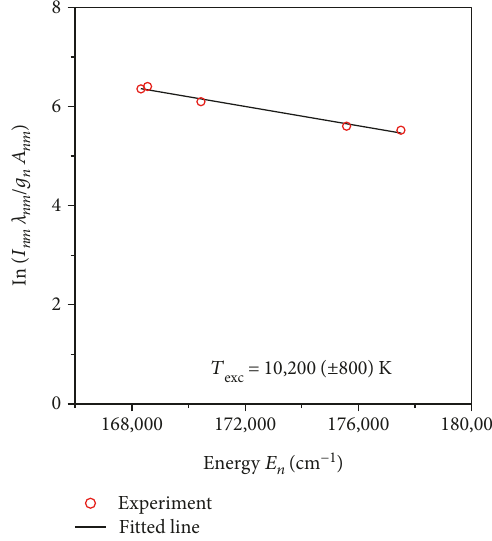
Figure 3: Example of Boltzmann plot for determination of the T — intensity of the recorded emission line from transition n → m , I nm microwave power absorbed P Q =50